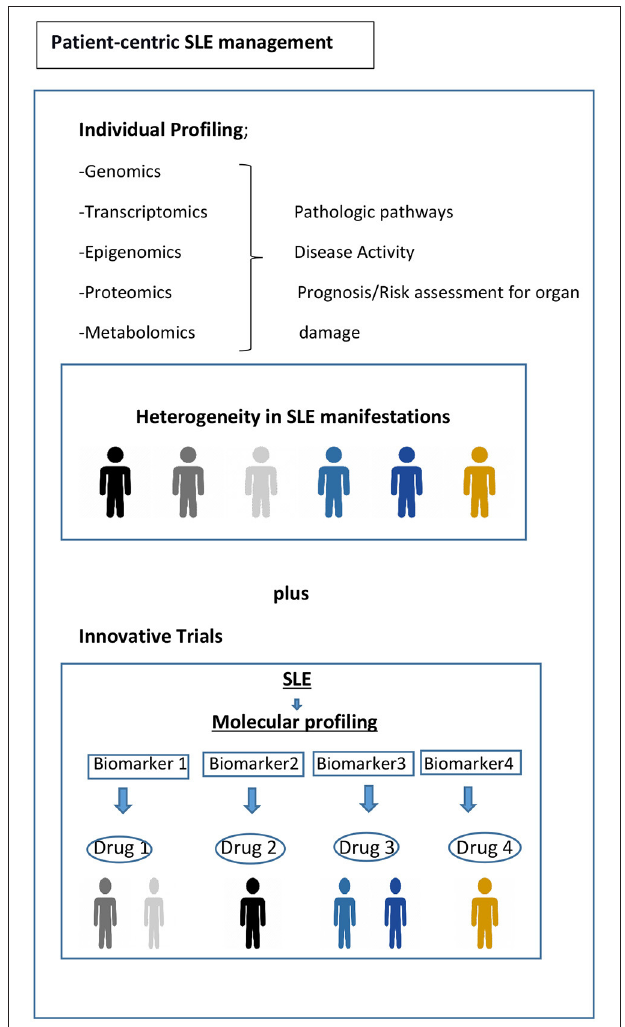
FIGURE 1 | Toward precision medicine. Molecular profiling of patients at time of diagnosis and throughout their disease course would be helpful to assess the drivers of main pathophysiological pathways, to predict organ damage accrual and flares, and to offer optimum treatment and follow-up. Biomarker driven trial designs are proposed here. Adapted from REF (